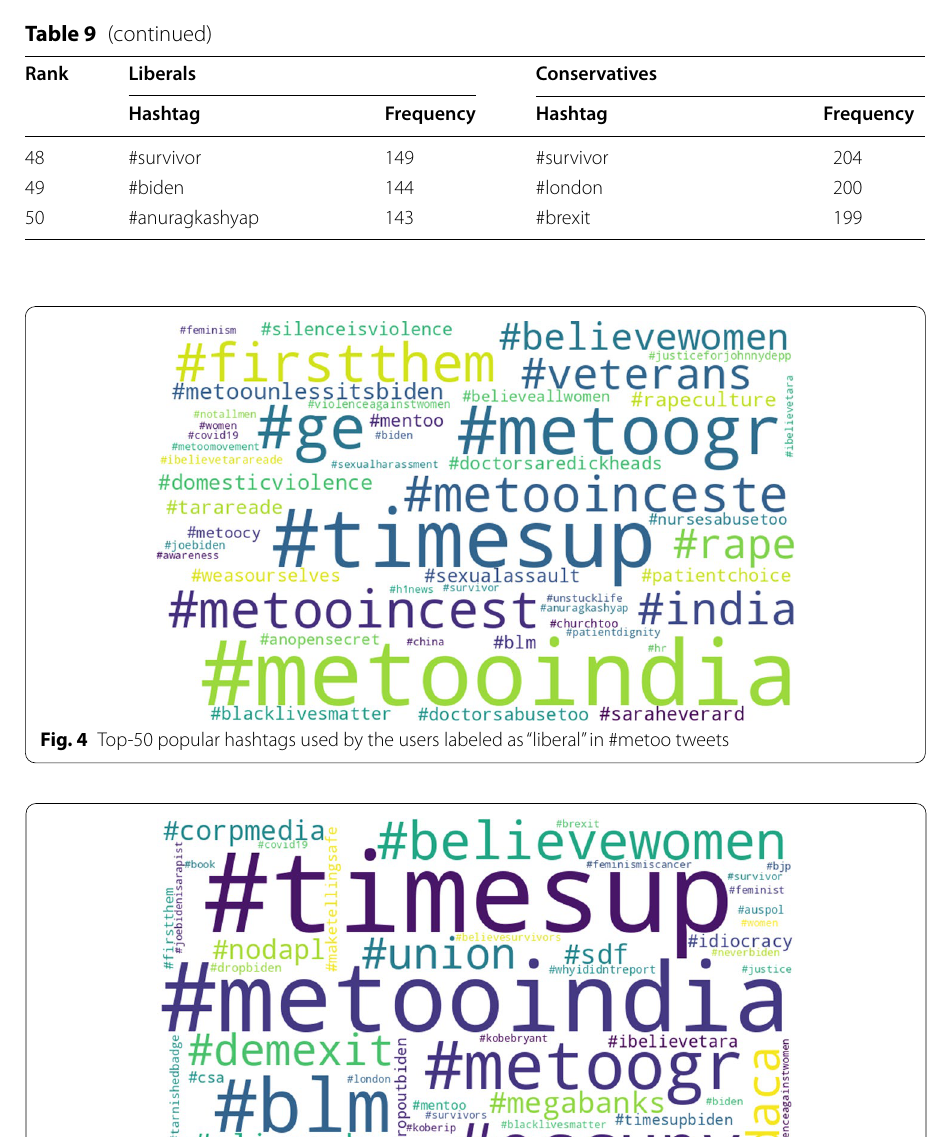
in which larger hashtags represent more popular ones. Noticeably, the two hashtag clouds present somewhat different hashtags, as they have only 16 hashtags in common. 15